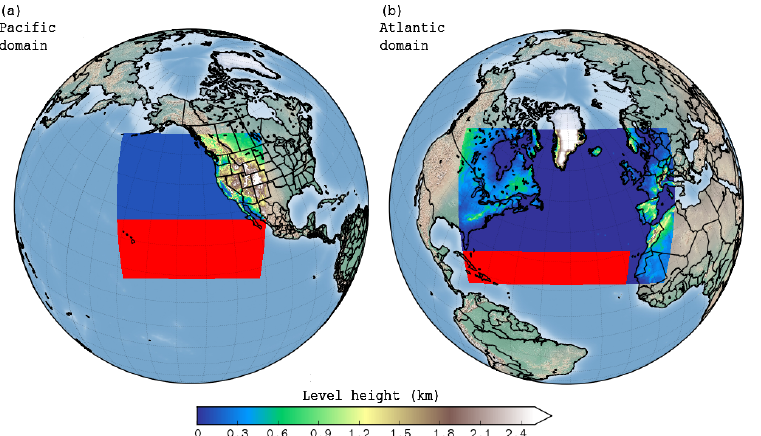
Figure 3. Domains of the WRF simulation (blue) for the Great Coastal Gale of 2007 (a) and the Great Storm of 1987 (b) . Areas highlighted in red correspond to the masked region where the moisture is initially labeled as tracer.